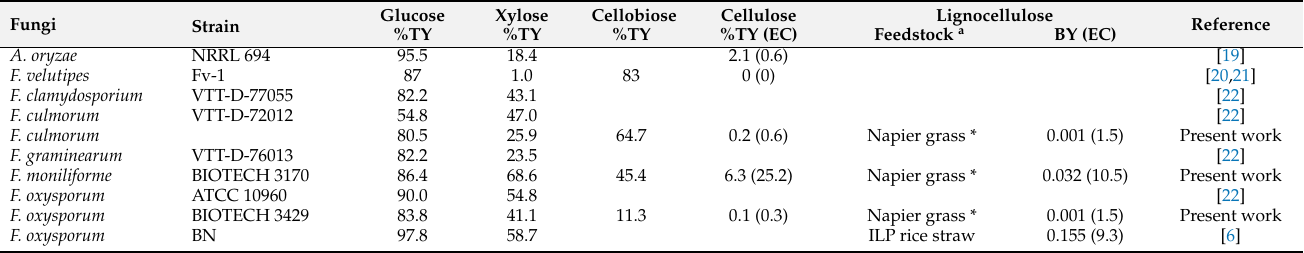
Table 2. Ethanol production performance from diverse carbon sources by various filamentous